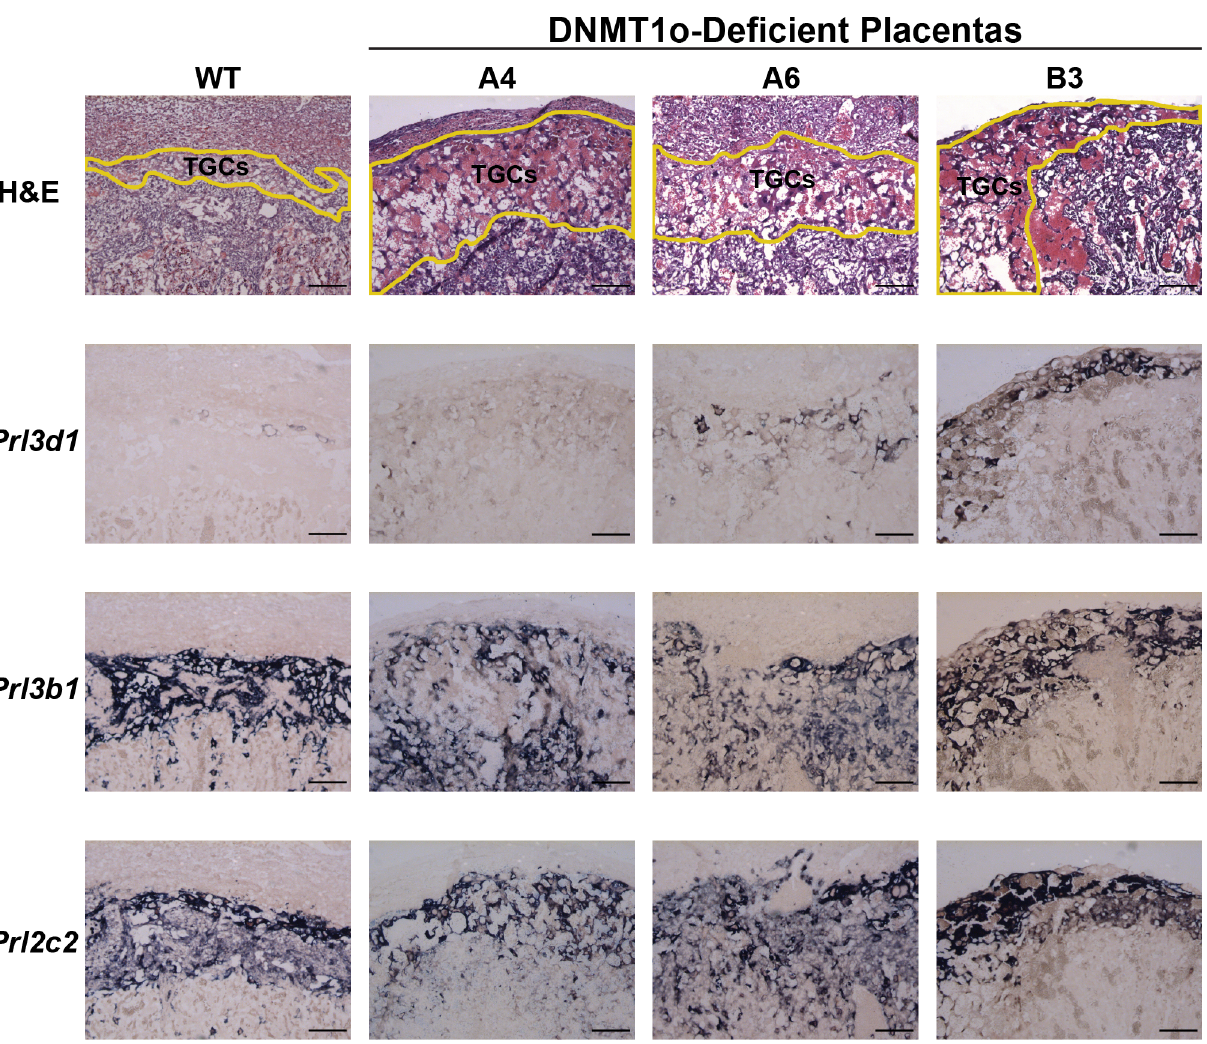
Fig 5. In situ hybridization analysis of TGCs in E12.5 wild-type and DNMT1o-deficient placentas with low Kcnq1 gDMD methylation. All images were taken at 100X magnification. The scale bar is 100 μ m. Yellow lines delineate the layer containing trophoblast giant cells (TGCs) in the top row displays histology of hematoxylin and eosin (H&E) stained sections. ISH for the prolactin gene family members Prl3d1 , Prl3b1 and Prl2c2 on adjacent sections to H&E are shown in the lower three